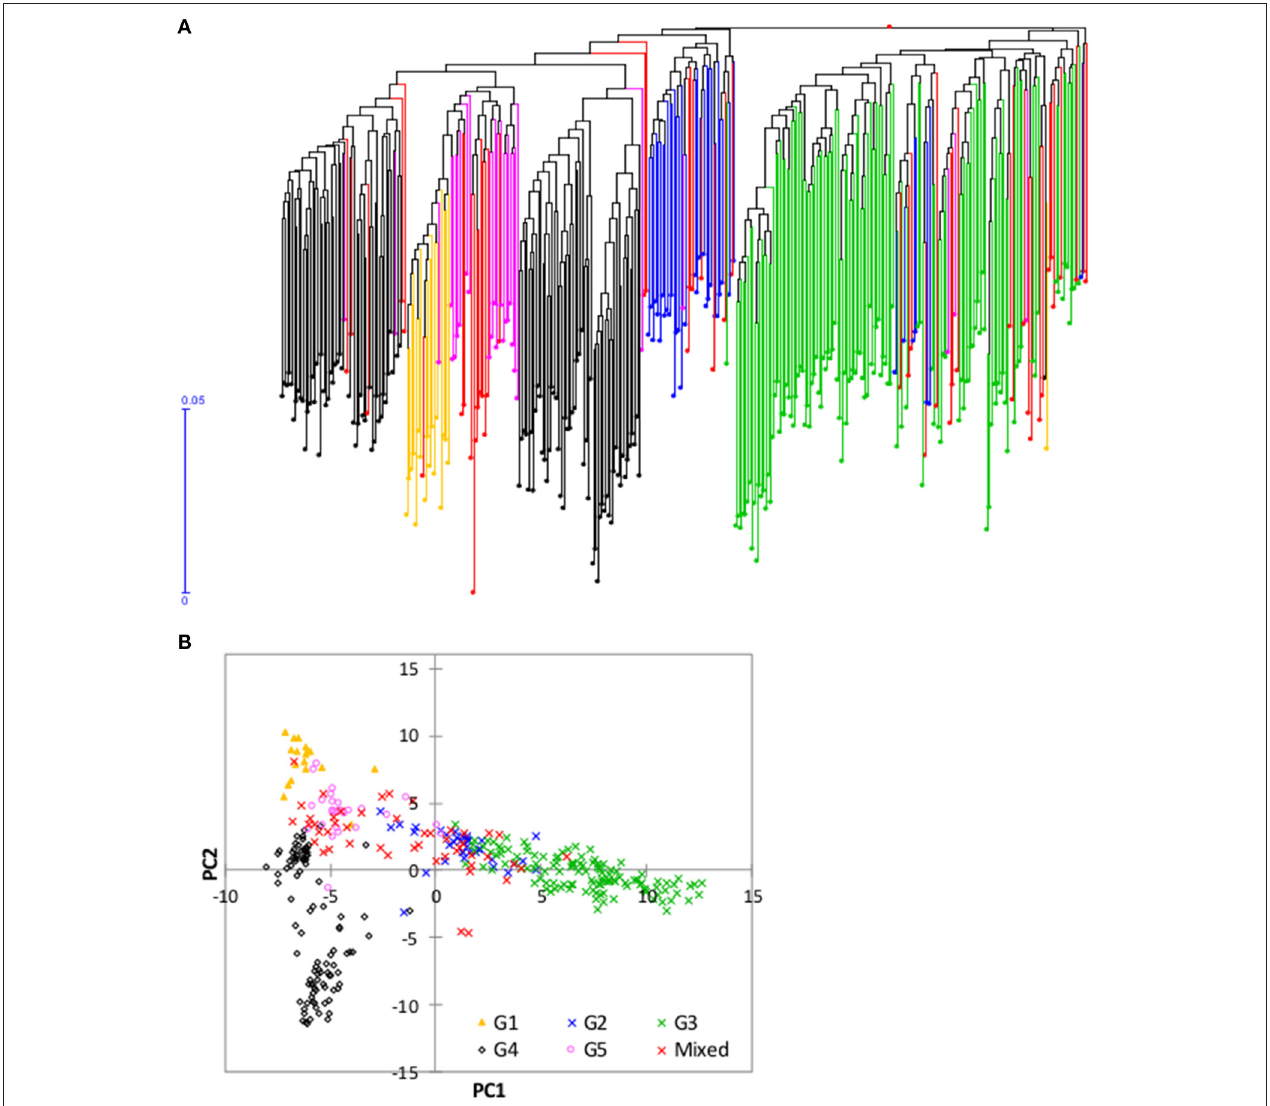
FIGURE 5 | Neighbor joining tree and principal component analysis of the 350 mini-core accessions based on 3,709 of the 3,834 SNPs that were polymorphic within this set; (A) Neighbor joining tree from DARwin; and (B) plot of PC1 (10.6%) and PC2 (5.7%) from principal component analyses. Accessions belonging to each of the five groups predicted based on STRUCTURE in Figure 3 are shown with the same color (Group 1, orange font; Group 2, blue font; Group 3, green font; Group 4, black font; Group 5, pink font, and mixed, red font). See Supplementary Table S1 for details.